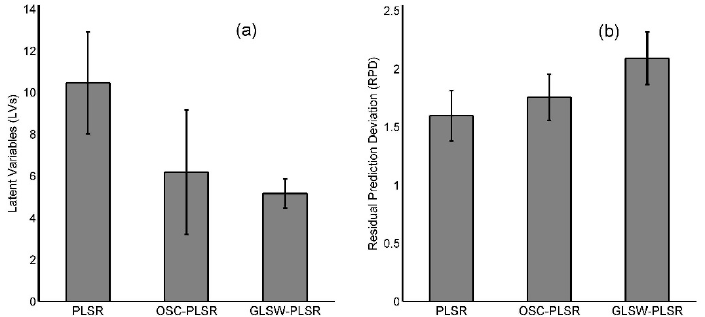
Figure 6. Mean values of ( a ) LVs and ( b ) RPD in prediction of SOC content at various moisture contents using three methods: PLSR, OSC-PLSR, and GLSW-PLSR, respectively. The error bars denote one standard deviation.